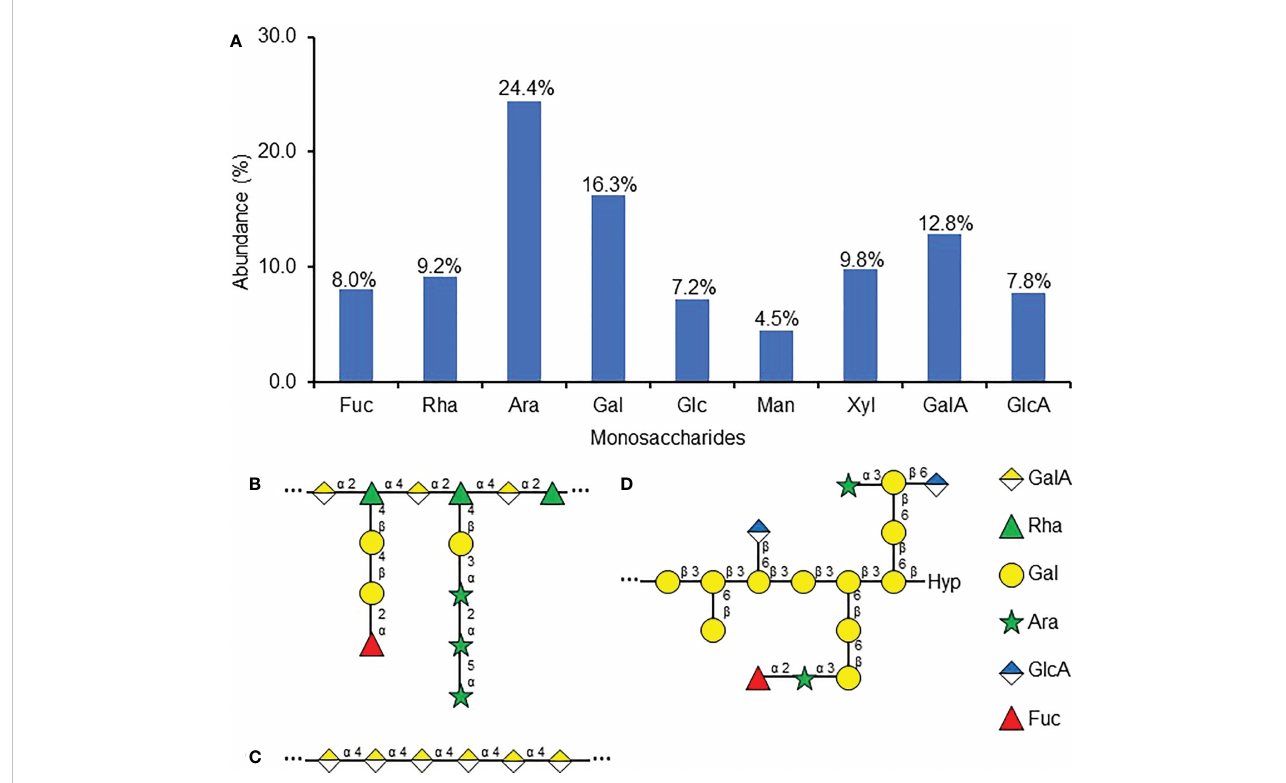
FIGURE 4 Monosaccharide composition of puri fi ed RKN attractant from SR culture media. (A) Relative abundances of monosaccharides detected in the puri fi ed RKN attractant from SR culture media. Numbers denote the numerical values of fucose (Fuc), rhamnose (Rha), arabinose (Ara), galactose (Gal), glucose (Glc), mannose (Man), xylose (Xyl), galacturonic acid (GalA), and glucuronic acid (GlcA). (B – D) Representative structures of cell wall polysaccharides that may be present in the puri fi ed attractant based on the monosaccharide analysis, including RG-I (adapted from Mohnen, 2008) (B) , HG (adapted from Mohnen, 2008) (C) , and AGP (adapted from Tryfona et al., 2012) (D) , Hyp, hydroxyproline. “…” denotes that the backbone structures repeat. The right panel shows the symbols used to represent the